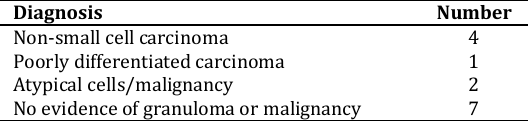
Table 1. Diagnosis obtained by radial probe endobronchial ultrasound-guided biopsy